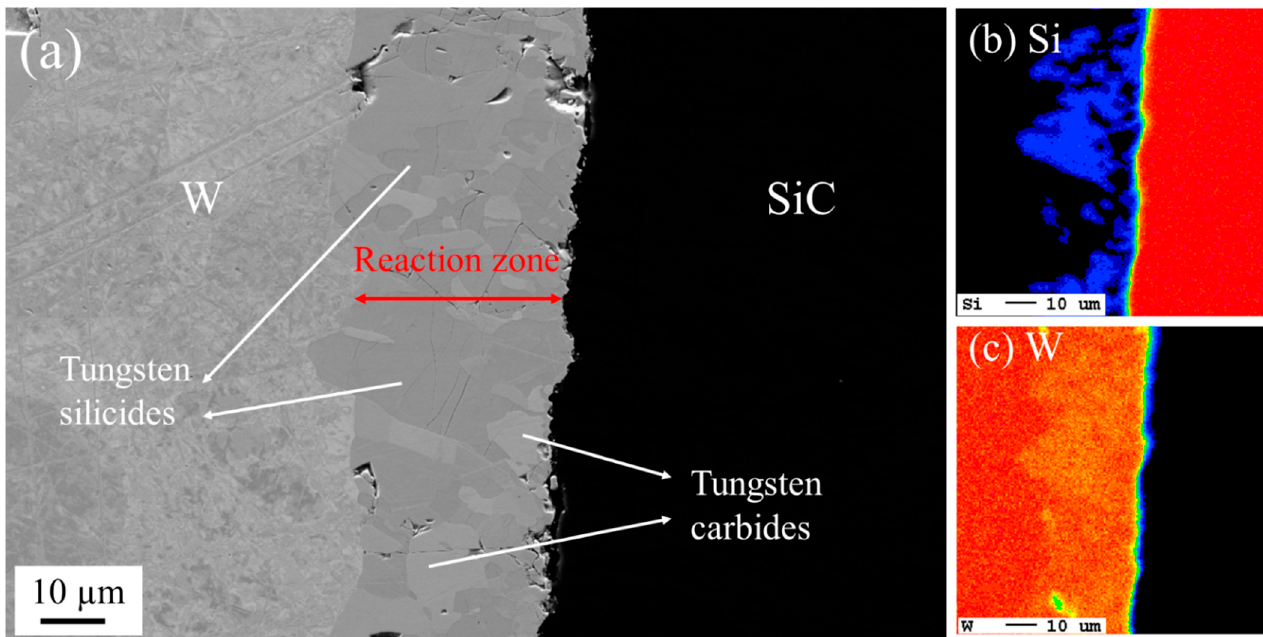
Figure 2. The cross-sectional SEM image with secondary electron mode (image ( a )) and element distribution by EPMA (image ( b ) for Si; image ( c ) for W.) of joined CVD-SiC and W foil without diffusion barriers at 1700 °C, 20 MPa for 1 h.